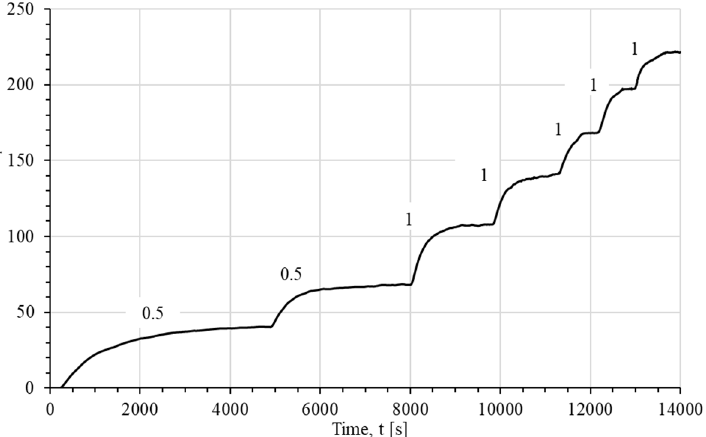
Figure 6. Evolution of the permeation current density over time for QT700-7 d grade ( J c = 0.5 + 0.5 +